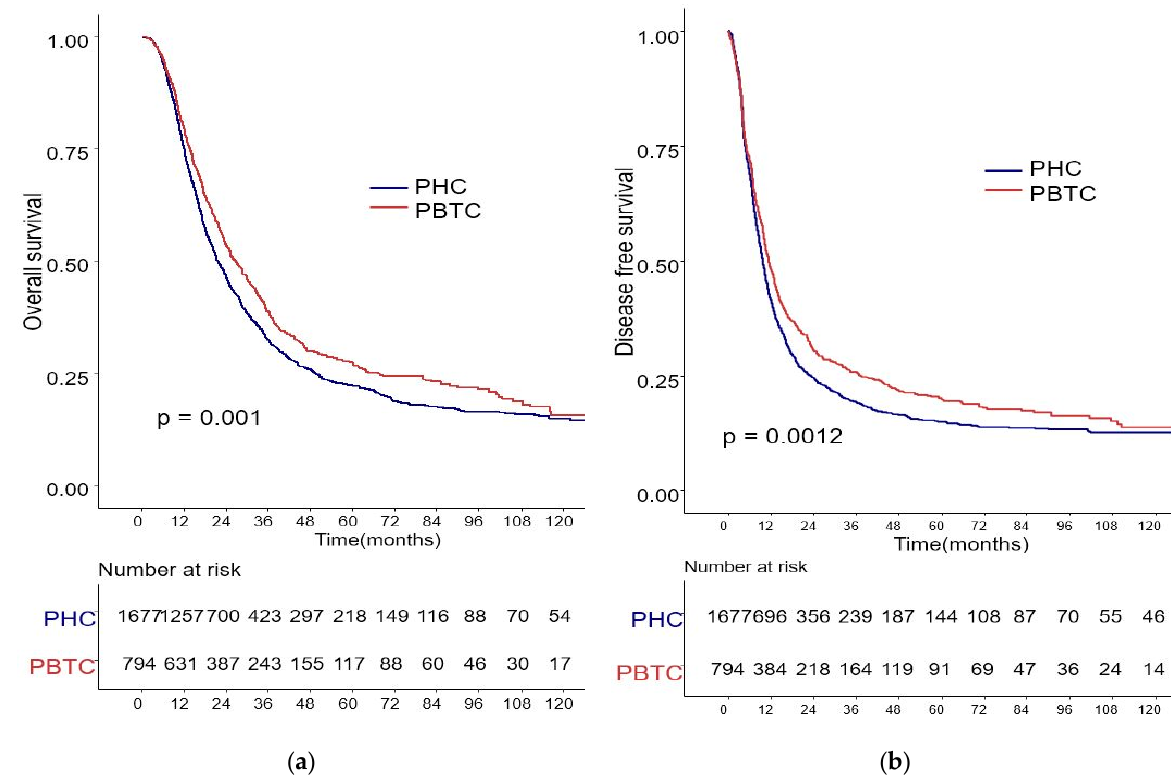
Figure 1. Kaplan–Meier survival curves of the cases in pancreatic head cancer (PHC) group ( n = 1677) and pancreatic body/tail cancer (PBTC) group ( n = 704). ( a ) The median overall survival (OS) and estimated 1-, 3-, and 5-year OS rates were 24.0 months and 75.0%, 25.2%, and 13.0% in the PHC group, and 34.0 months and 79.5%, 30.6%, and 14.7% in the PBTC group, respectively ( p = 0.001). ( b ) The median disease-free survival (DFS) and estimated 1-, 3-, and 5-year DFS rates were 12.0 months and 41.5%, 14.3%, and 8.6% in the PHC group, and 18.0 months and 48.4%, 20.7%, and 11.5% in the PBTC group, respectively ( p = 0.0012).